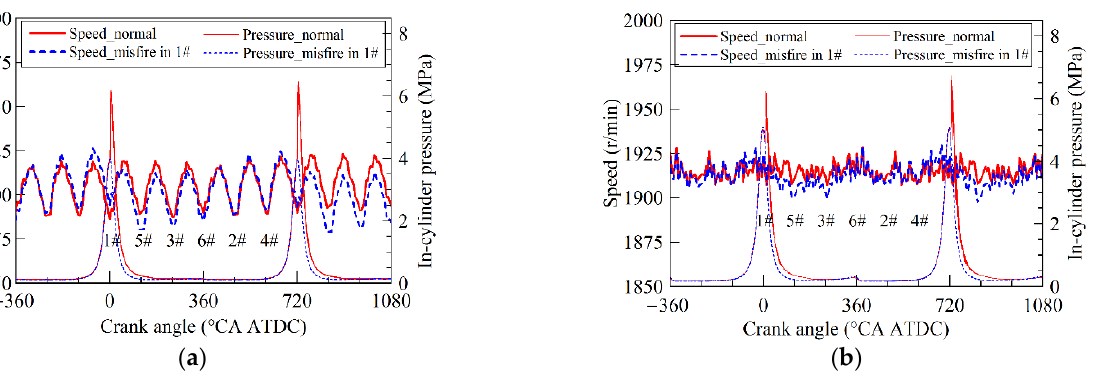
Figure 3. In-cylinder pressure and corresponding engine speed under normal and cylinder 1# misfire conditions. ( a ) Under 1000 r/min and 100 Nm. ( b ) Under 1900 r/min and 100 Nm.